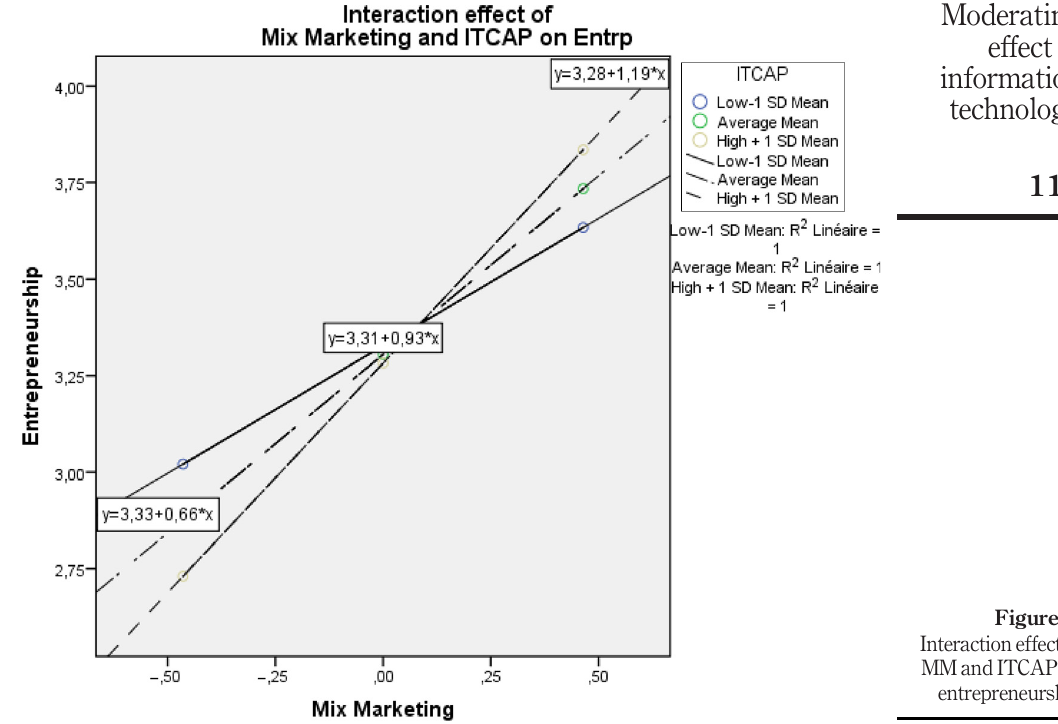
Figure 1. Interaction effect